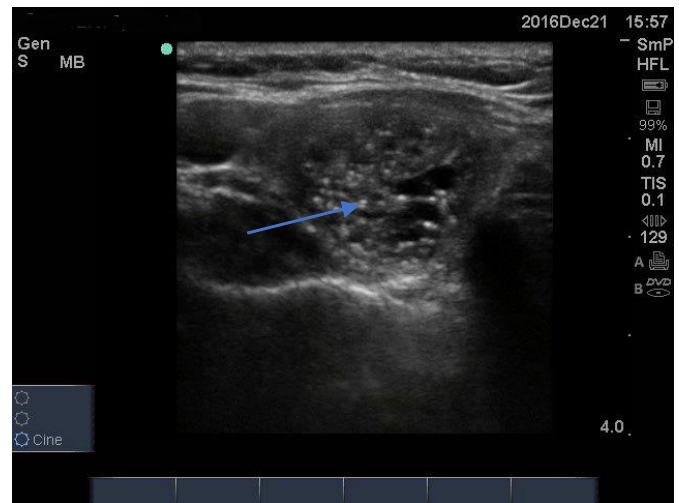
Figure 3. A benign nodule with a series of bright intramodular microcalcifications (arrow). These spots need to be differentiated from the larger softer (less bright) microcalcifications which are often found in papillary thyroid cancer.